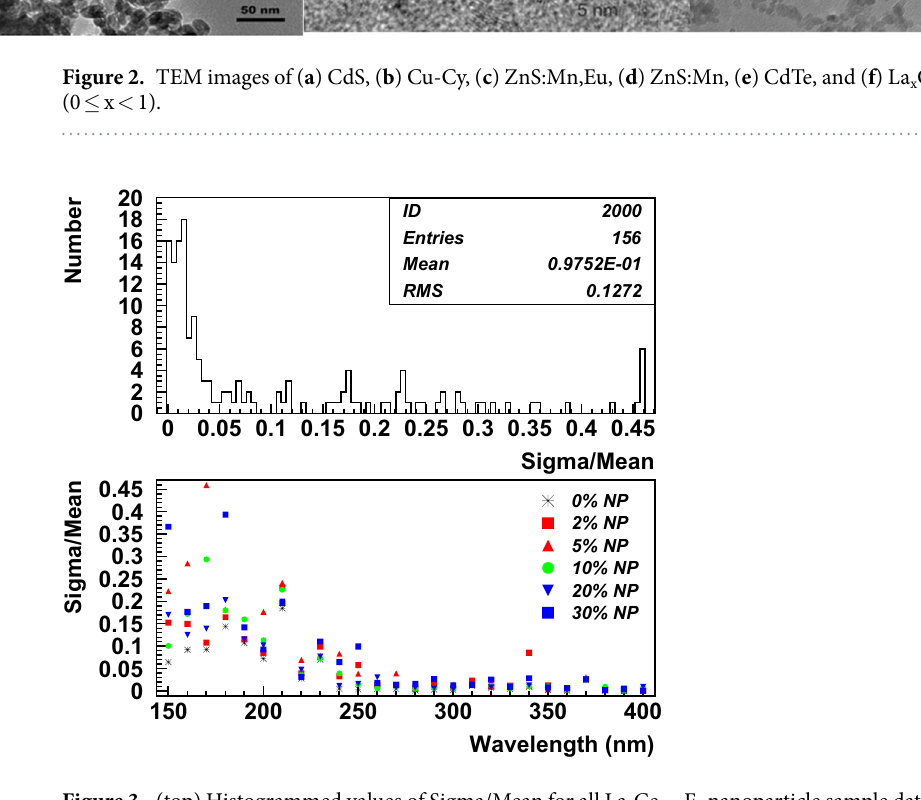
Figure 3. (top) Histogrammed values of Sigma/Mean for all La x Ce 1 − x F 3 nanoparticle sample data, (bottom) Sigma/Mean versus wavelength for all